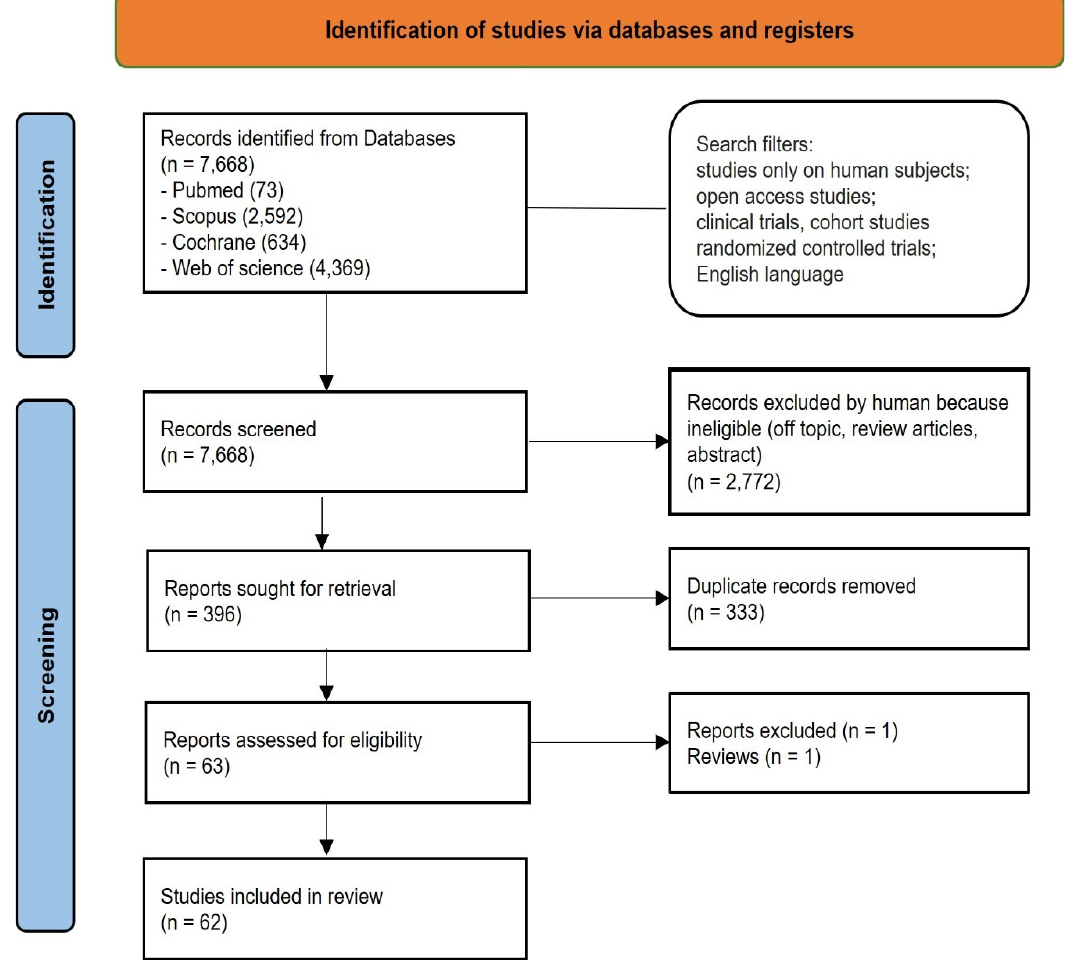
Figure 2. Literature search Preferred Reporting Items for Systematic Reviews and Meta-Analyses (PRISMA) flowchart diagram of the inclusion process.